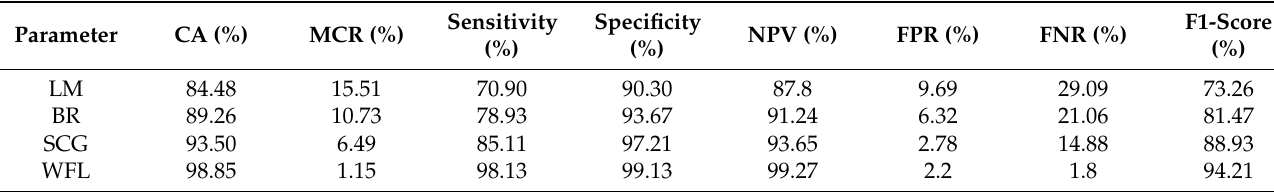
Table 6. Statistical performance of LM, BR, SCG, and WFL.